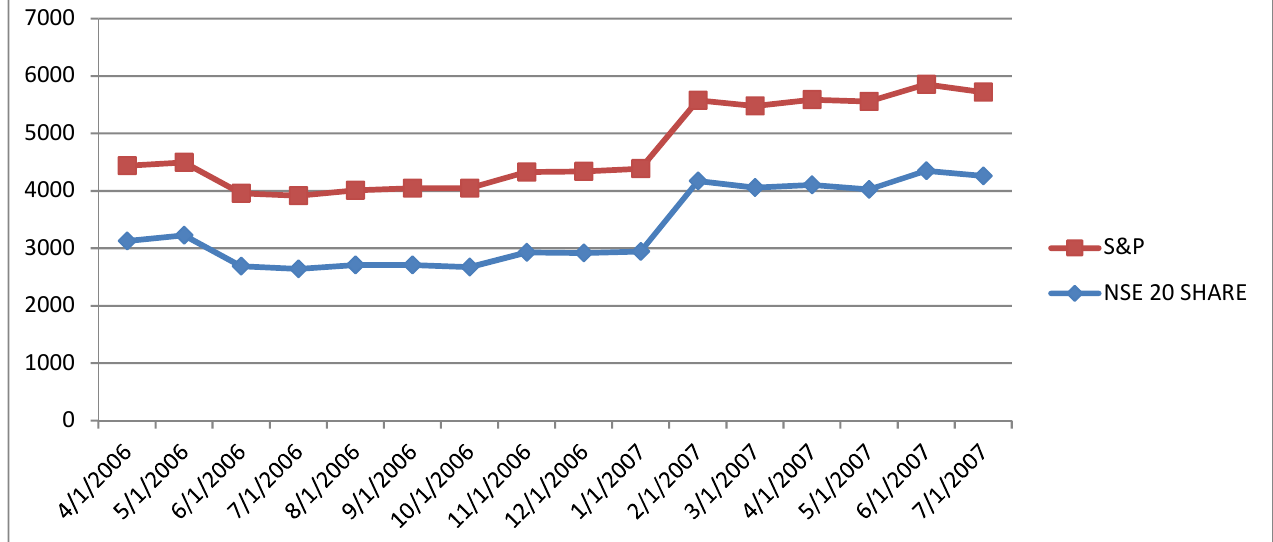
Fig. 2 . Influence of NSE 20 Share Index on Standard and Poor’s During the Pre-Crisis Period